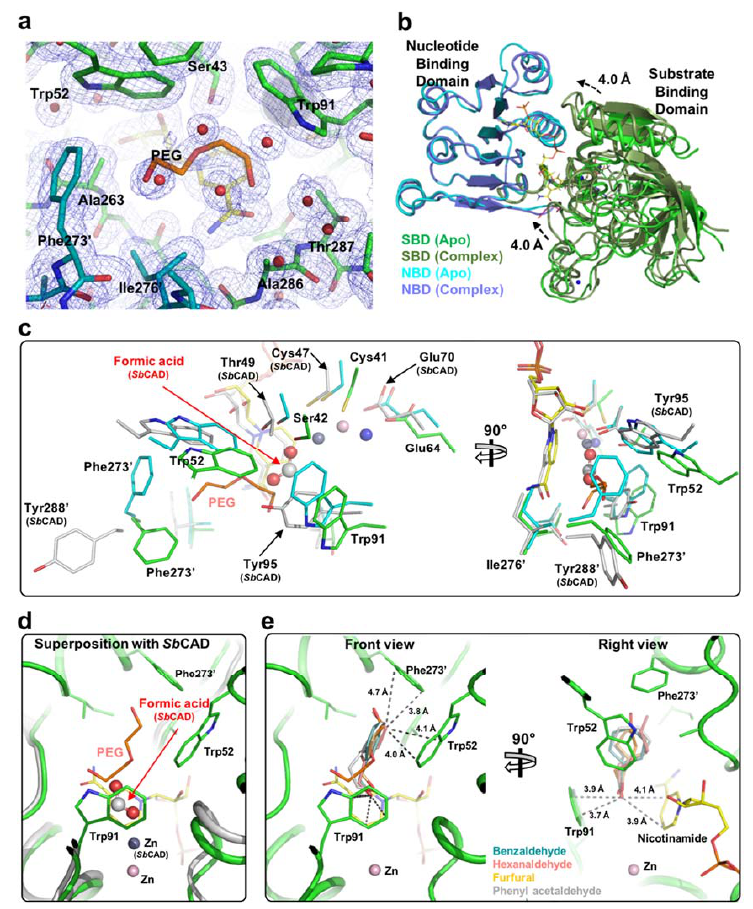
Figure 4. Active site and Docking simulation. ( a ) Electron density map of the active site in the Ec YjgB-NADP-polyethylene glycol (PEG) complex structure. The 2Fo-Fc densities including PEG are shown at the 1.0 σ contoured level with a dark-blue colored mesh. The monomer and its symmetry related molecule are colored in green and cyan, respectively. ( b ) Conformational di ff erence between the apo and complex structure. The SBD (substrate-binding domain) of the apo and complex structures and NBD (nucleotide-binding domain) of the apo and complex structures are colored as green, dark green, cyan, and light purple, respectively. ( c ) Conformational change in the active site. Apo, NADP complex, and closed form of Sb CAD (PDB code: 5VKT) are colored in green, cyan, and gray colors, respectively. Formic acid in Sb CAD is represented as a ball and stick with gray-colored carbon and red-colored oxygen. Zinc ions of apo-YjgB, Ec YjgB-NADP, and closed form of Sb CAD are represented as light-blue, light-pink, and silver spheres, respectively. PEG in the Ec YjgB-NADP structure are drawn as stick with orange carbon and red oxygen. ( d ) Docking-simulation and comparison with PEG and formic acid of Sb CAD. Ec YjgB-NADP structure and Sb CAD are colored in green and silver, respectively. Formic acid in Sb CAD is represented as corresponded to Figure 4c. Zinc ions of Ec YjgB-NADP, and closed form of Sb CAD are shown in light-pink and gray spheres, respectively. PEG in the Ec YjgB-NADP structure are drawn as stick with orange-carbon and red-oxygen. ( e ) Two side views of active site in the Ec YjgB-NADP complex structure. Overlaid ligands calculated from the docking simulation are shown as indicated colors. Dashed lines represent the acceptable distances in π - π stacking. Light-pink sphere indicates the catalytic zinc of Ec YjgB-NADP